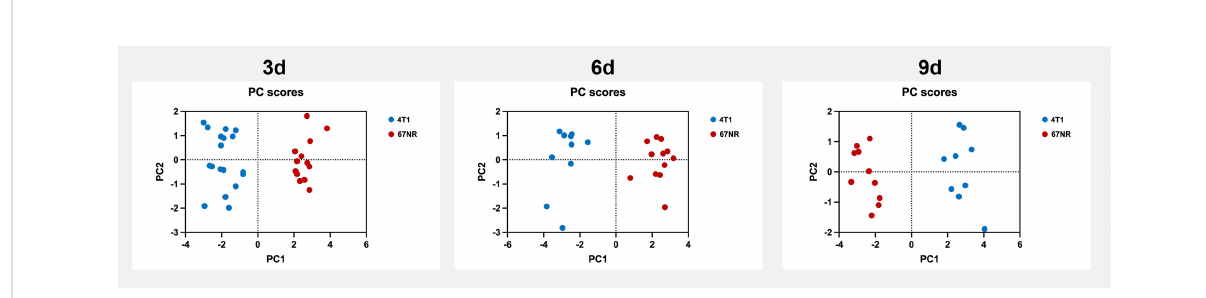
FIGURE 9 Principal component analysis score plots of the assessed multiparametric MRI data. Principal component analysis score plots revealed a clear discrimination of the highly malignant metastatic 4T1 tumors and the non-metastatic 67NR tumors, based on the presented multiparametric MRI data. Shown are the fi rst two principal components (PC1 and PC2). The fi rst principal component (PC1) already explained 56.5% (3d), 71.4% (6d) and 76.5% (9d) of the total variance. Detailed values can be found in Supplementary Tables 2 –